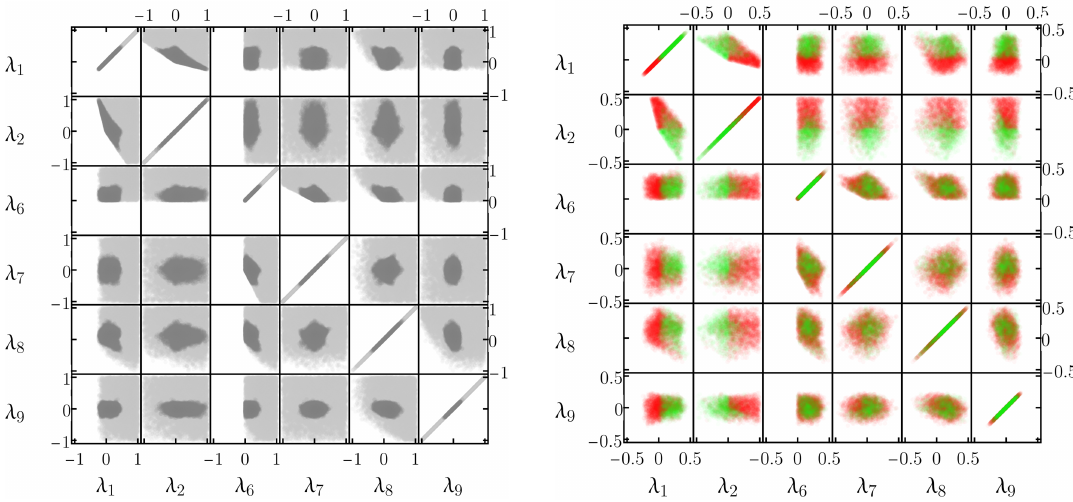
Figure 3 . Successive constraints (I.a-c), cf. section 2, on the 6-parameter Planck-scale theory space of quartic couplings (we suppress the subscript M in the λ ) in an SO(10) GUT with Pl i | M Pl 16 H + 45 H scalar matter content. The left-hand panel shows a statistical scatter-plot matrix of constraints arising from (I.a) stability (light-gray regions) and from (I.b) perturbativity (dark-gray regions). The right-hand panel shows a zoomed-in scatter-plot matrix of additional constraints (I.c) arising from the deepest radiative minimum occurring in a non-admissible direction (red/darker points). The green/lighter points in the right-hand panel remain potentially viable, see also figure 4.